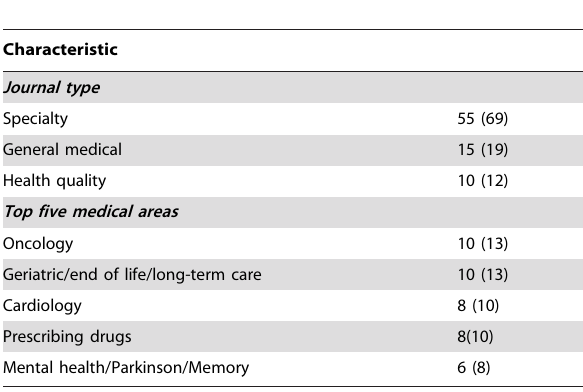
Table 1. Characteristics of the 80 selected